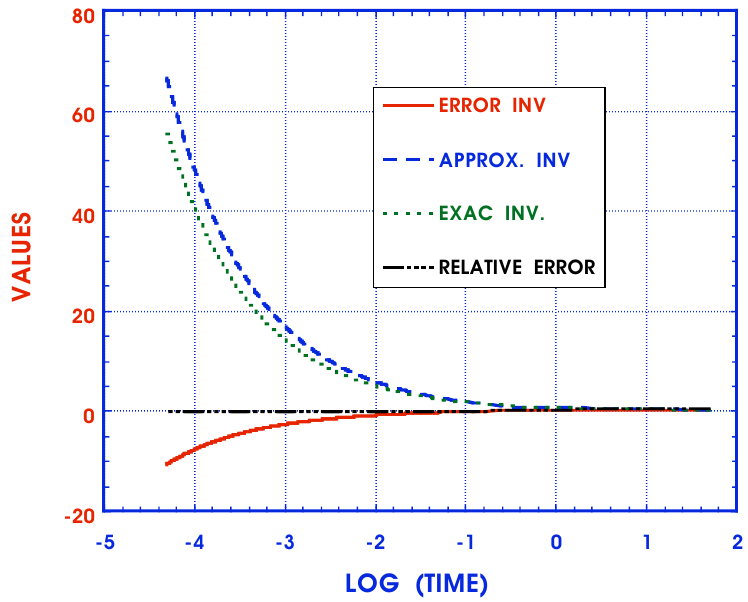
Figure 4. Fractional derivative